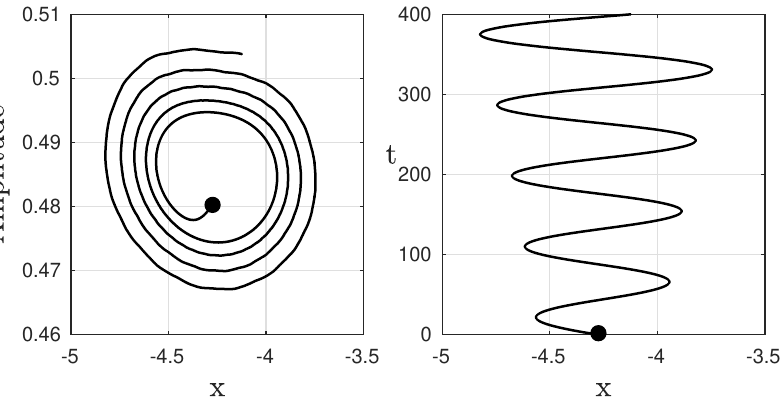
Figure 5. Left : the space amplitude vs. crest position. Right : the crest position along the time. The parameters are the same as in Figure 4 with n = 60.